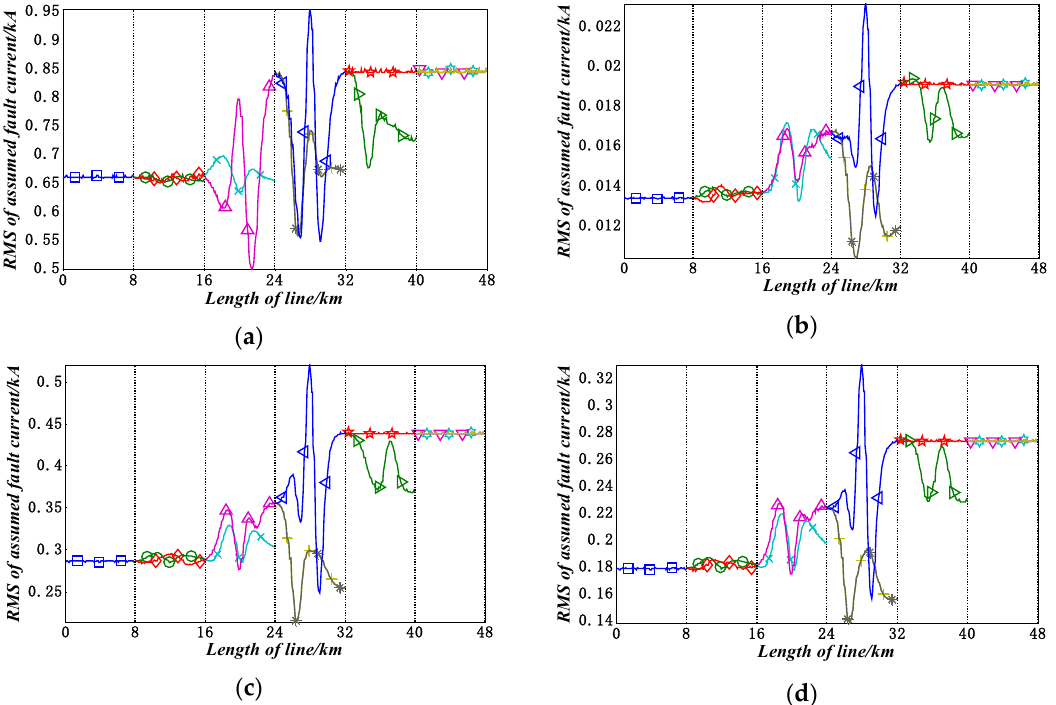
Figure 9. Results of fault line selection for different fault types and resistances: ( a ) SLG fault with resistance of 0 Ω ; ( b ) SLG fault with resistance of 100 Ω ; ( c ) LL fault with resistance of 30 Ω ; ( d ) LLG fault with resistance of 30 Ω .